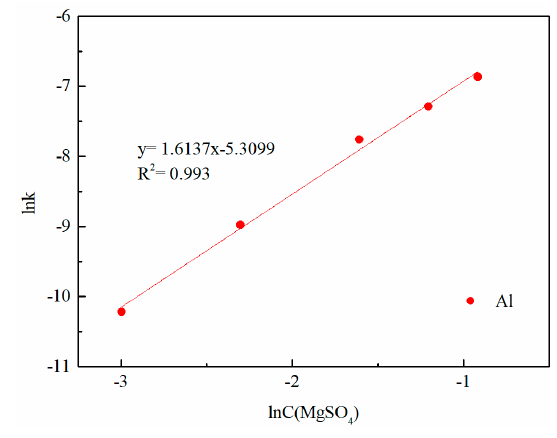
Figure 10. Plot of lnk as a function of magnesium sulfate concentration.